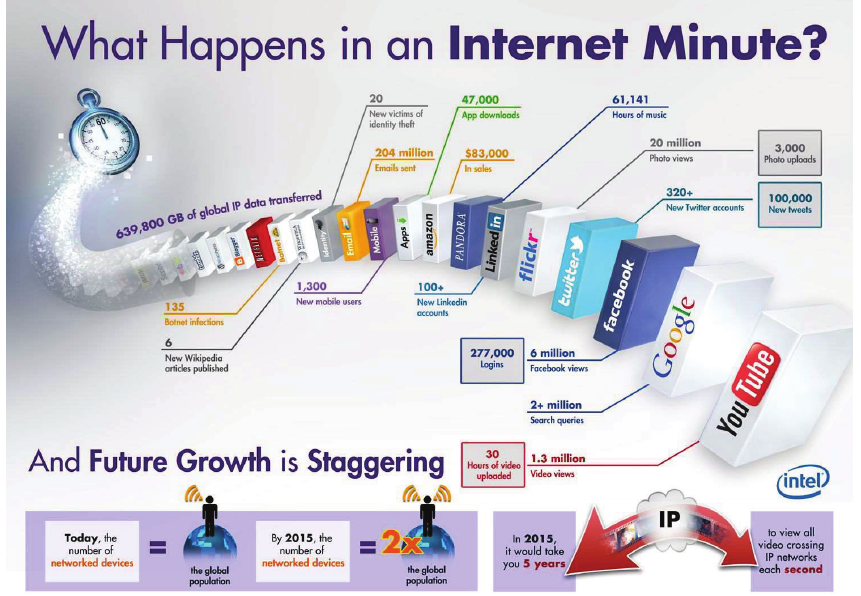
Fig. 1. Volume of data generated per minute